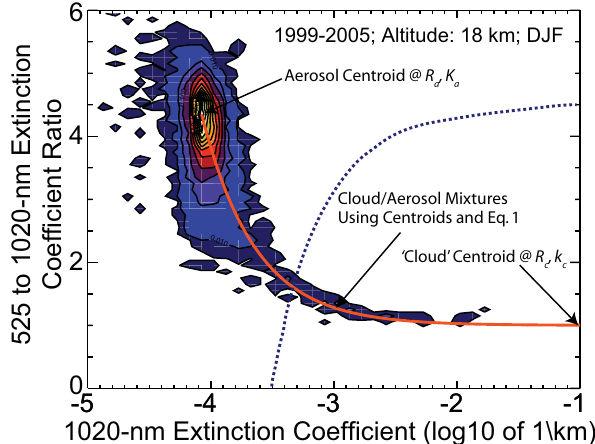
Fig. 4. A typical density function for SAGE II aerosol extinction co- efficient observations at 18km in DJF for 1999 through 2005. The density is scaled to a value of 1 at the peak value with contours at 0.1 increments (0.9, 0.8, etc.) and additional contours at 0.05, 0.01, 0.005 and 0.001. The dotted line shows the approximate position of the “Kent method” cloud/aerosol demarcation. The red line shows the effect of mixing a nominal dense “cloud” with varying frac- tions of aerosol (values from the centroid of the distribution) using Eq.